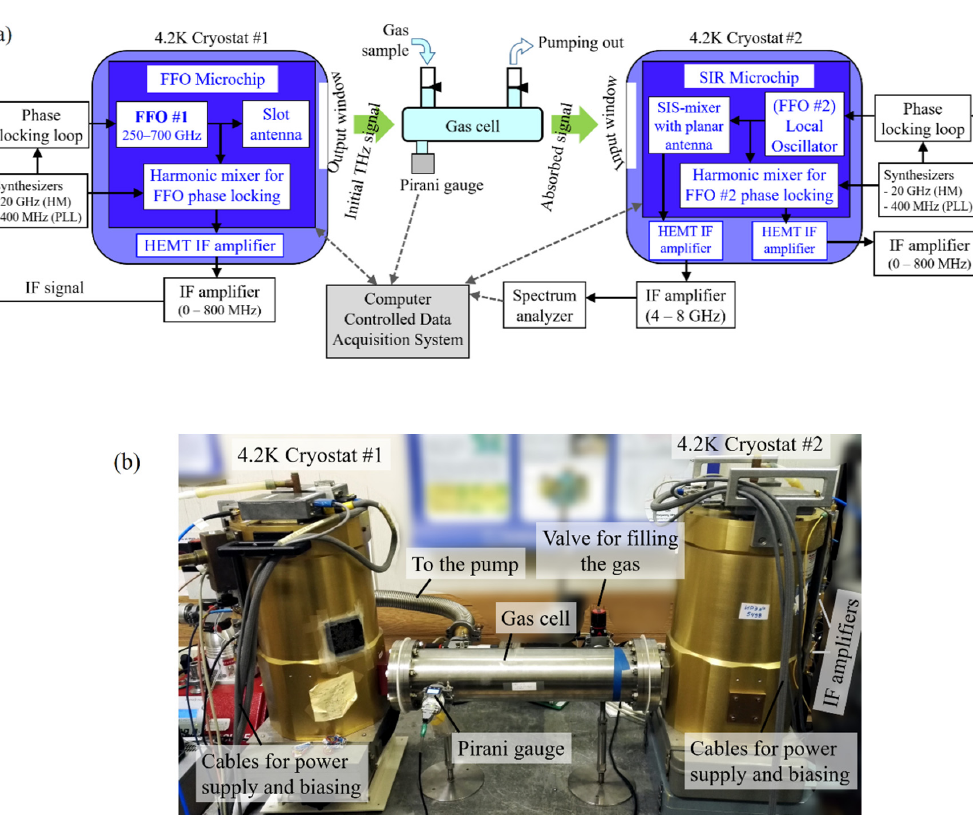
Figure 3. ( a ) Block diagram of the setup for detection of the gas absorption lines by means of the FFO-based active source and the superconducting integrated receiver (SIR)-based THz spectrometer; ( b ) Photo of the setup showing the main parts. Auxiliary parts (computer, synthesizers, biasing and power supply devices, spectrum analyzer etc.) are beyond the photo or on the back of the